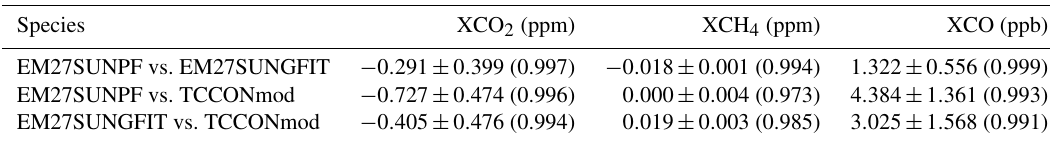
Figure 13. Correlation plots for XCO 2 (a) , XCH 4 (b) , and XCO (c) retrieved from EM27/SUN measurements processed following the COCCON recommendations (EM27SUNPF) and using GFIT (EM27SUNGFIT) for measurements performed at Sodankylä in 2017. Table 7. Statistics of the intercomparison results for EM27/SUN and non-linearity-corrected TCCON with different retrieval procedures for measurements performed in 2017 with SZA < 75 ◦ . The values provided are the mean bias ± the standard deviation and the correlation coefficient ( r